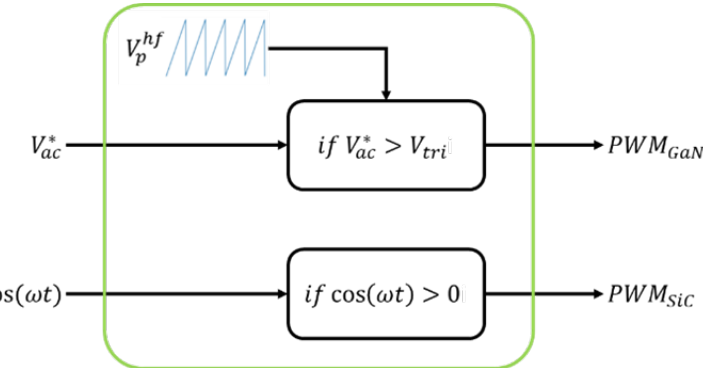
Figure 7. Schematic representation of the modulation block.